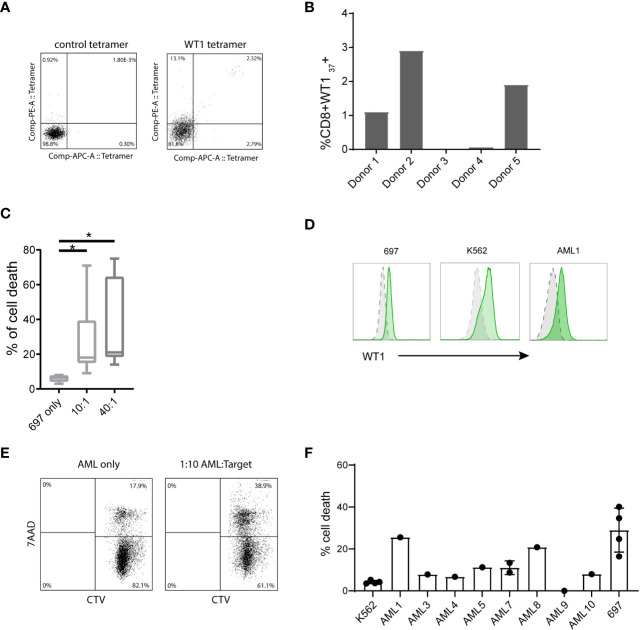
T-cell activation by cord blood-derived dendritic cell (CBDC) and subsequently acute myeloid leukemia (AML) lysis by CB WT1+ T-cells. (A) Gating example of WT1-pulsed T-cells, analyzed by either CMV tetramer (negative control) or WT1 tetramer. (B) Frequency of CD8+WT137+ generated from naïve bulk T-cells stimulated by peptivator loaded CBDCs. (C) Percentage of cell death of HLA-A2+ WT1+ 697 cell line in the absence of T-cells or in a 10:1 or 40:1 ratio with CD8+WT1+ T-cells generated from different donors. Target T-cells were labeled with cell tracer dye (CTV) and lysis was assessed detecting % 7-AAD+ CTV+ target T-cells. (D) Example of intracellular WT1 levels (green) of 697, K562 and primary AML1 compared to isotype control (grey). (E) Gating of lysed target cells, pre-gated on CTV+. (F) Percentage of cell death of primary pediatric AML compared to K562 (negative control) or 697 as a positive control. Error bar represents multiple killing assays (2–4) and represents SD. Statistical analysis is performed in GraphPad Prism using Kruskal-Wallis test.